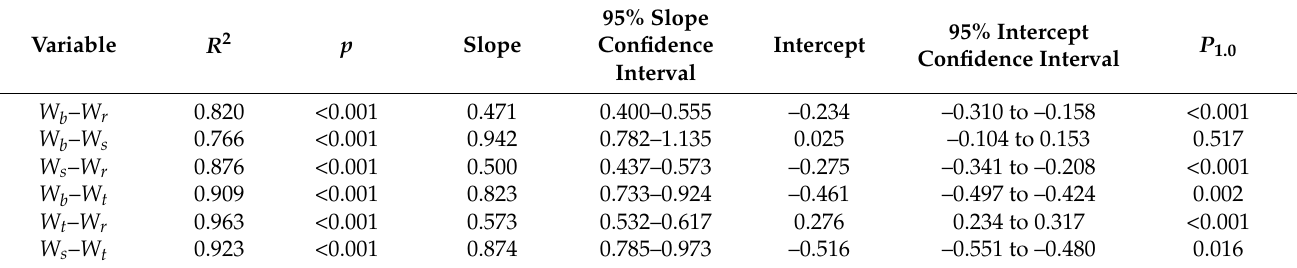
Table 3. SMA analysis results of organs and total biomass of Sargassum fusiforme .